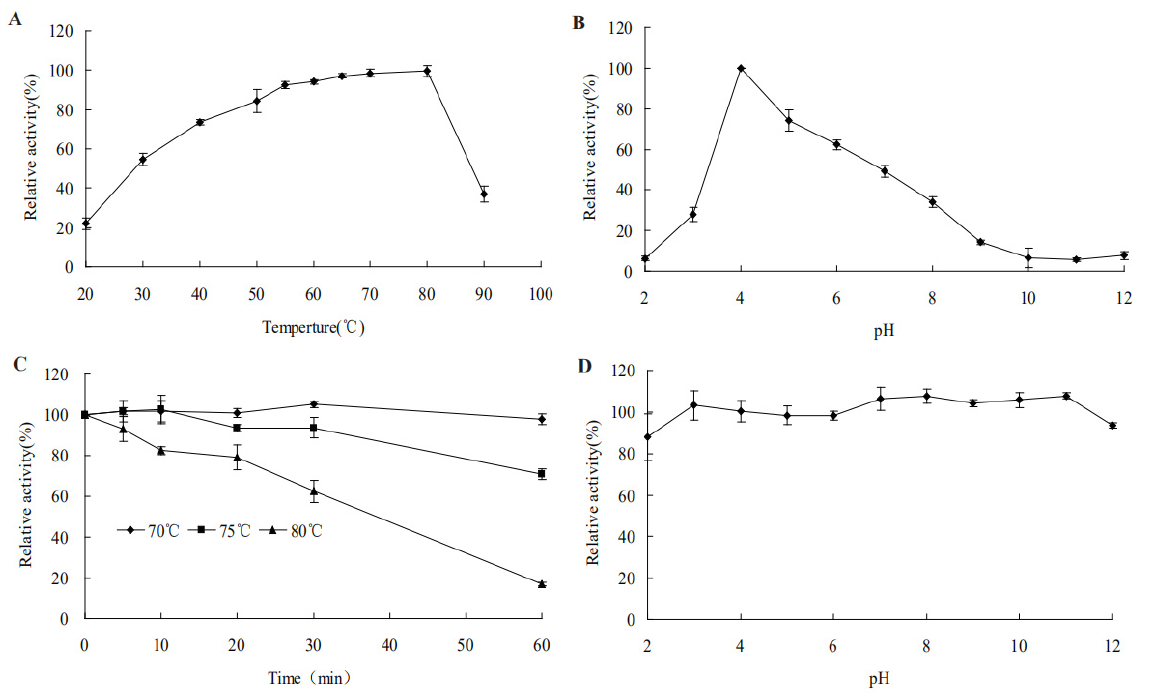
Figure 3. Characteristics of the endoglucanase AfCel5A. ( A ) The optimum temperature for endoglucanase activities. ( B ) The optimum pH for endoglucanase activities. ( C ) The thermostability of AfCel5A at 70, 75 and 80 °C. ( D ) The pH stability of AfCel5A at different pH values.